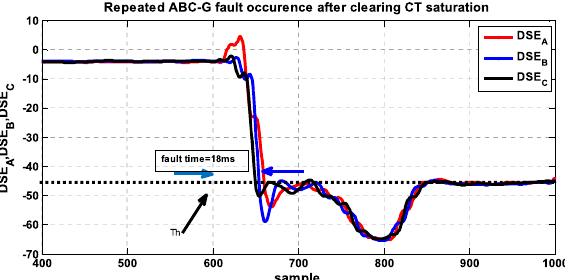
Fig. 9 Repeated ABCG fault after clearing CT